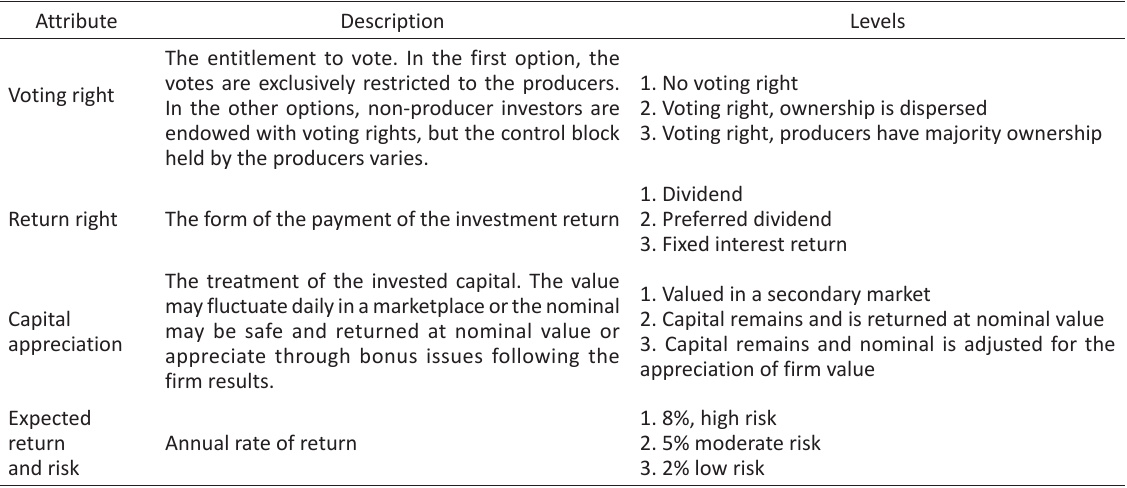
Table 2. Attribute description and levels used in the investment choice experiment Attribute Description